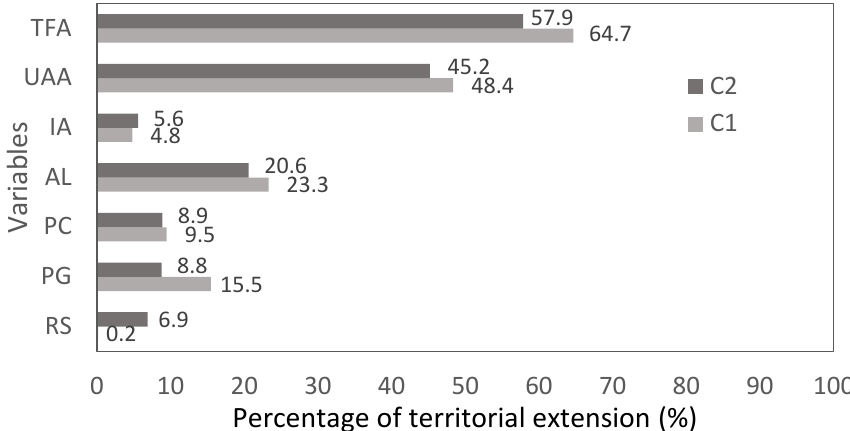
Figure 3. Percentage of surface occupied by each variable in relation to the total territorial extension of the study-area (TFA = total farm area; UAA = utilized agricultural area; IA = irrigated area; AL = arable land, PC = permanent crop, PG = permanent grass and RS = remaining surface).